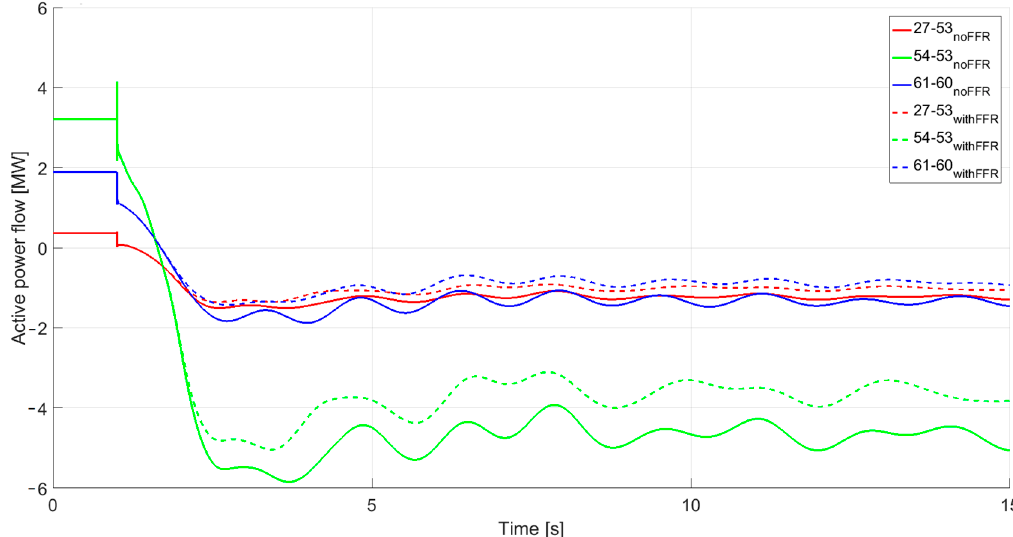
Figure 24. Active power flow on lines connecting Area 1 and Area 2.